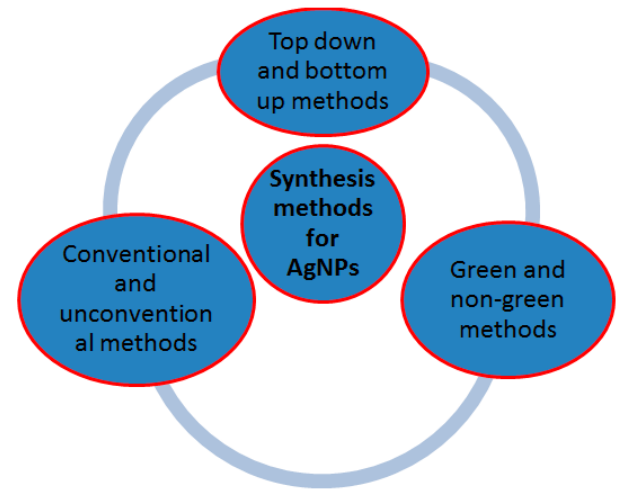
Figure 2. Synthesis methods for silver nanoparticles.